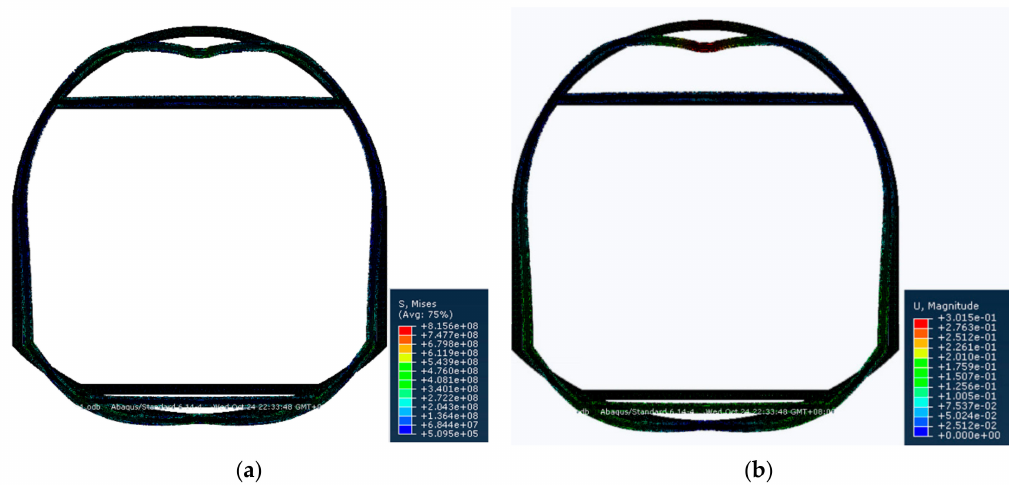
Figure 22. The stress nephogram and deformation nephogram of the RFB